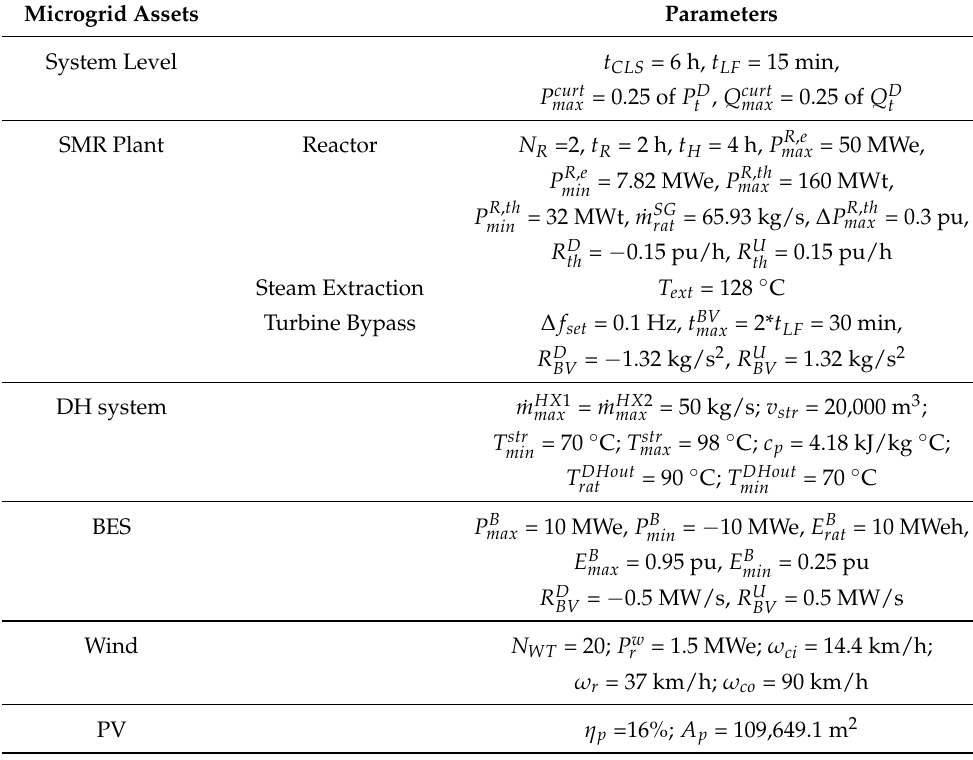
Table 1. Microgrid design